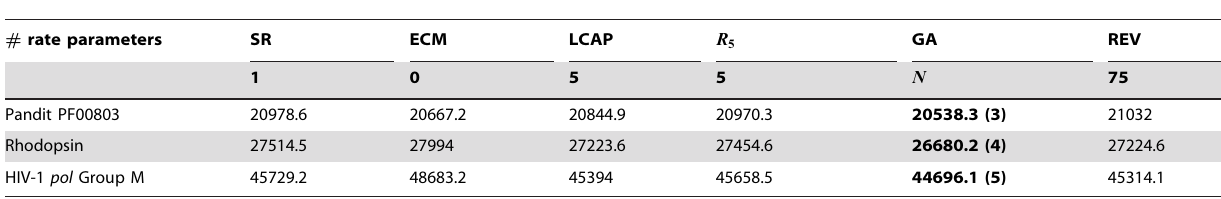
The best model (with smallest BIC) is shown in boldface. The BIC for R 5 , the model in which amino acid substitution pairs are randomly assigned to one of 5 rate classes, is estimated as the mean BIC over 100 permutations of rate class assignment. N is the number of rate classes identified using a Genetic Algorithm model fitting procedure described in [20] and shown in parenthesis for each alignment. All models were fitted using maximum likelihood estimates of position-specific nucleotide